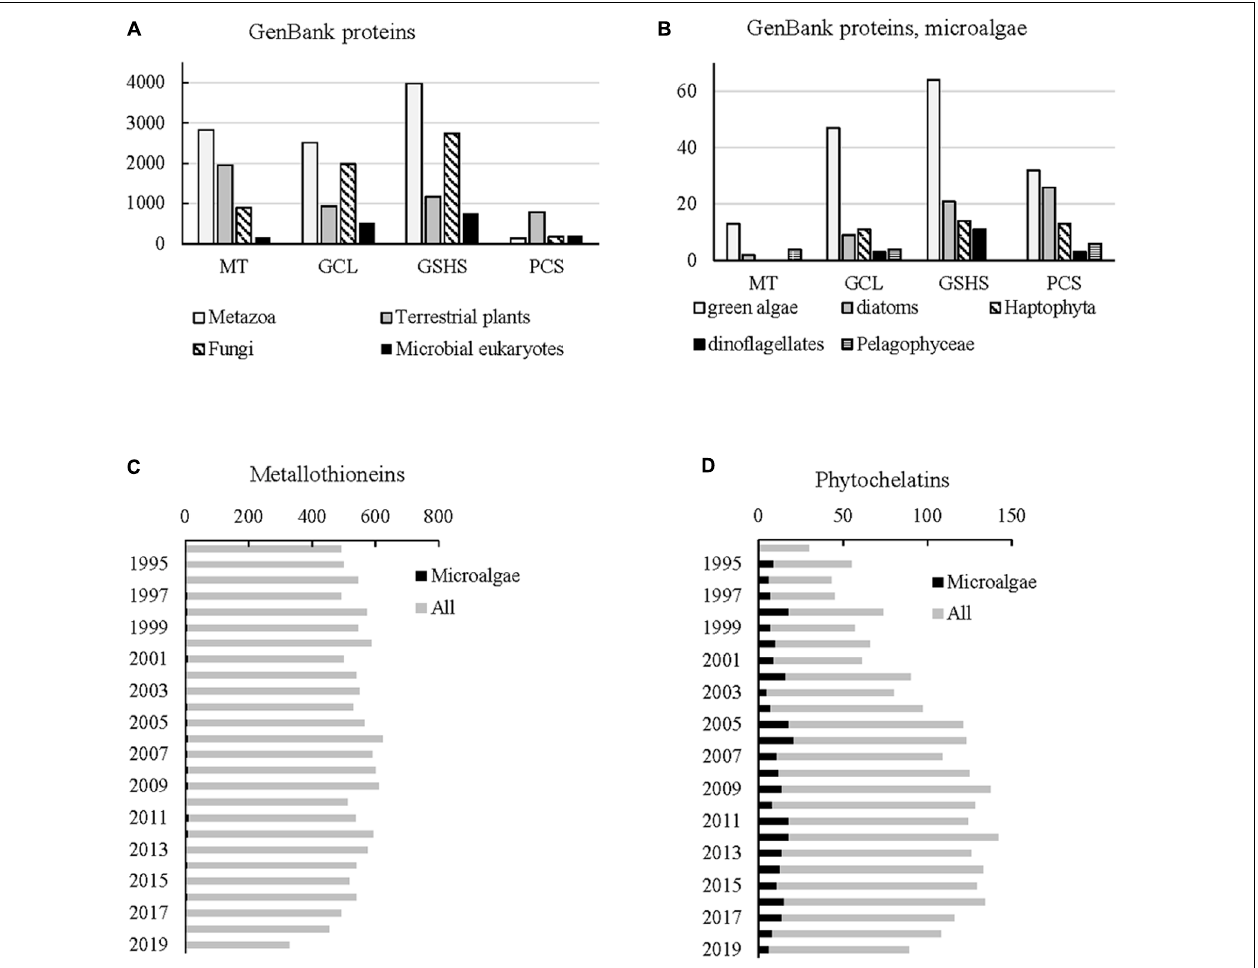
FIGURE 2 | Current knowledge about metallothioneins and phytochelatins. (A,B) Taxonomic origin of the GenBank proteins annotated as metallothionein (MT), glutamate–cysteine ligase (GCL), glutathione synthase (GSH), and phytochelatin synthase (PCS) for (A) all eukaryotic organisms and (B) within eukaryotic microalgae. Please note the different scale on the y-axis (C,D) number of papers, as reported by Web of Sciences (September 2019), containing the keywords (C) “metallothionein*” and (D) “phytochelatin*” alone or in association with the keywords “microalga*/phytoplankt*/phytobenth*.” Keyword searches were case